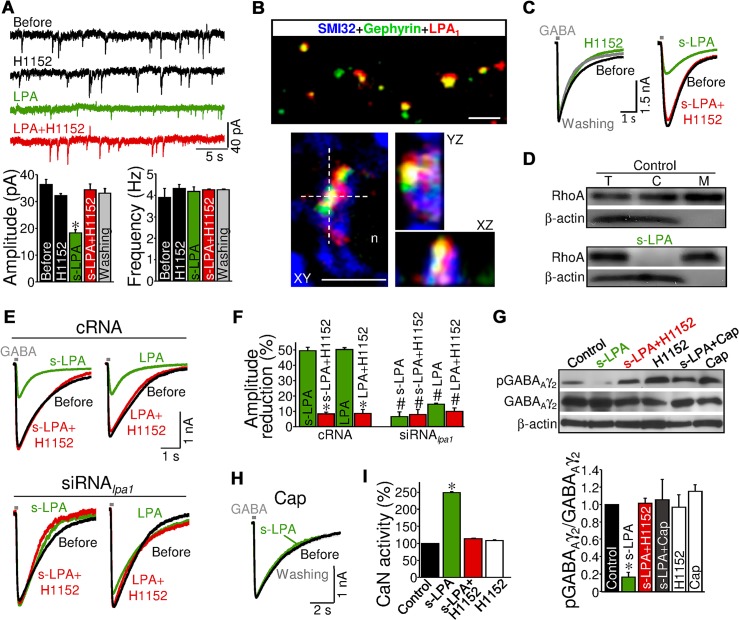
LPA induces GABAAergic STD and GABAAγ2 dephosphorylation via postsynaptic LPA1-RhoA/ROCK-CaN signaling.(A) Spontaneously occurring mIPSCsGABAA recorded from a representative HMN before and after perfusion with the indicated combination of drugs. Bottom, mean mIPSCsGABAA amplitude (left) and frequency (right) at indicated conditions (n = 5 HMNs). mIPSCsGABAA were pharmacologically isolated in the presence of 1 μM tetrodotoxin (TTX), 1 μM strychnine hydrochloride, 30 μM d-tubocurarine, 50 μM (DL)-APV, and NBQX (20 μM) continuously applied to the bath perfusion. *p < 0.05, one-way RM-ANOVA relative to the control (before) condition. (B) Multiple immunolabeling confocal images of the HN from P7 rats showing colocalization between LPA1-ir and gephyrin-ir (top). 3-D reconstruction (bottom) showing that LPA1-ir colocalizes with gephyrin in a SMI32-ir HMN. n, HMN nucleus. The xz- and yz-planes are located as indicated by the white dashed lines. Scale bars: 5 μm. (C) Whole-cell GABAAergic currents evoked by 100 ms pressure pulses of GABA (applied at saturating concentration; 1 mM) in two spinal motoneurons (SMNs) under indicated treatments. Recordings were performed in the presence of TTX in nominally Ca2+-free solution. (D) Western blots of total (T), cytosolic (C), and membrane-associated (M) RhoA in SMNs in untreated and s-LPA incubated (for 10 min) cultures. (E) Whole-cell GABAAergic currents evoked by pulses of GABA in SMNs preincubated with cRNA (top) or siRNAlpa1 (bottom) before and after superfusion with the indicated drugs. (F) Summary data showing the changes in GABAAergic currents measured in SMNs exposed at different treatments (n ≥ 5 SMNs per group). #, *p < 0.05, one-way ANOVA or RM-ANOVA, respectively, relative to s-LPA or LPA treatments of cRNA preincubated SMNs. (G) Western blot (top) and averaged ratio (bottom) of phosphorylated and total GABAAγ2 subunit protein levels (denoted as pGABAAγ2 and GABAAγ2, respectively) in SMNs incubated (10 min) with aCSF alone (control) or supplemented with indicated drugs. β-actin was an internal loading reference. (H) Same as in C under indicated treatments. SMNs were preincubated for 30 min with the calcineurin (CaN) autoinhibitory peptide (Cap; 50 μM). (I) Changes of CaN activity in lysates from cultured SMNs untreated (control) or treated for 10 min with the indicated drugs. *p < 0.05, one-way ANOVA on Ranks relative to control condition. Plots data can be found in S1 Data.